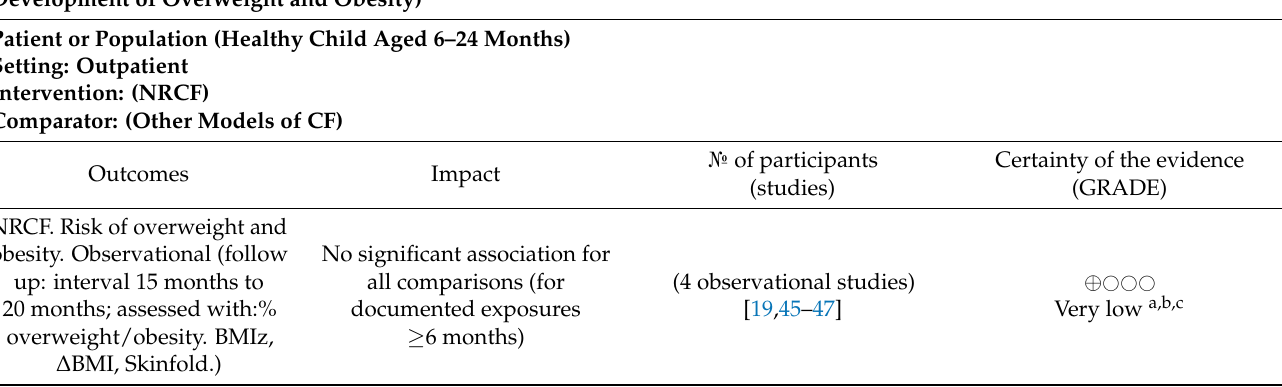
Table 4. NRCF and risk of overweight/obesity. Summary of findings for the main